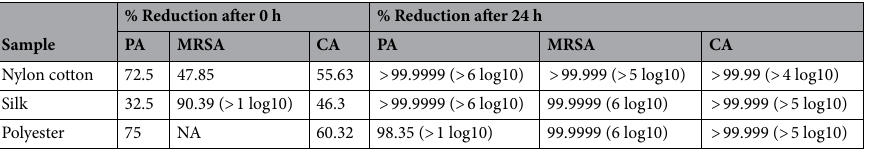
Table 1. Microbial reduction (%) of Pseudomonas aeruginosa (PA), methicillin resistant Staphylococcus aureus (MRSA) and Candida albicans (CA) after 0 h of incubation (immediate elution) and after 24 h with zinc nanocomposite textiles (The zinc nanocomposite textiles were washed once as part of the manufacturing process to remove loose particles; microbial reduction in terms of log reductions are provided for some of the samples in